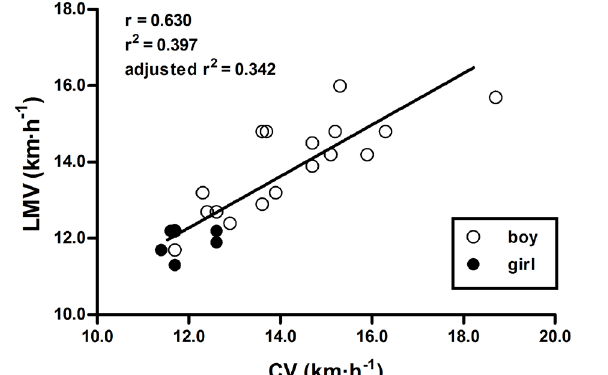
Figure 4. Linear regression adjusted by gender between critical velocity (CV) and lactate minimum velocity